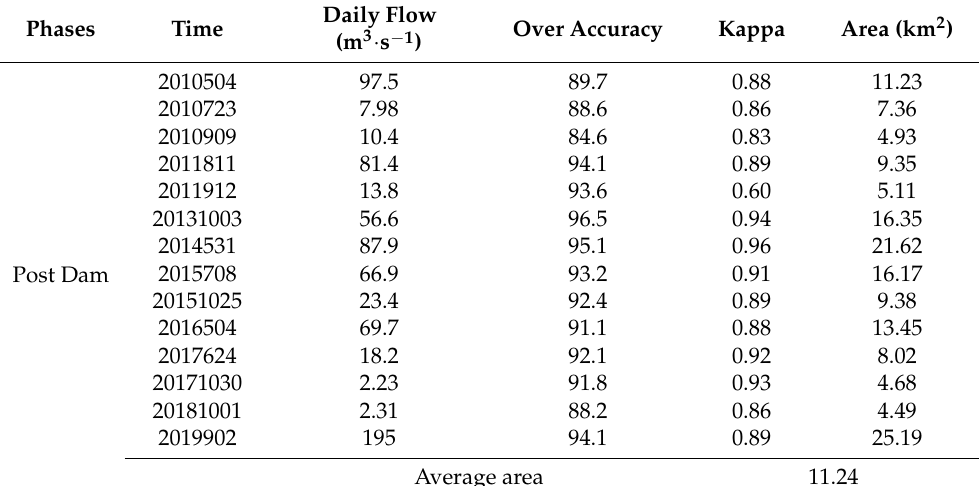
Table 3. Verification of the accuracy of the MNDWI, Kappa coefficient and water-inundation area in 14 periods after dam construction